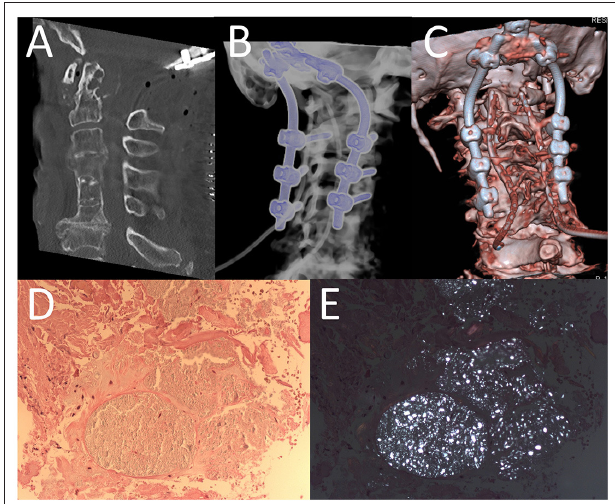
FIGURE 3 | Post-operative CT-scan of cervical spine (A) and different three-dimensional reconstruction (B,C) revealed a sufficient decompression and furthermore regular placement of screws. Histopathologic findings of bioptic probe showing fibrous connective tissue (HE x 200) (D) with multifocal deposits of birefringent crystals (under polarized light x 200) (E) .